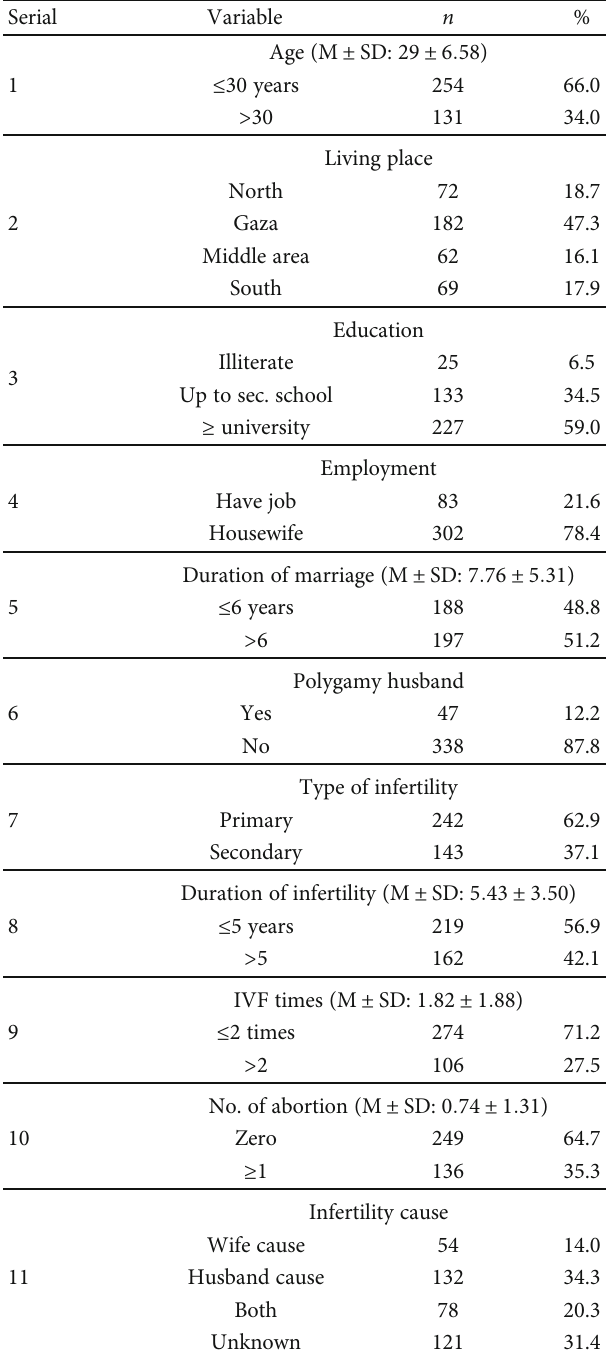
Table 1: Baseline characteristics of participated